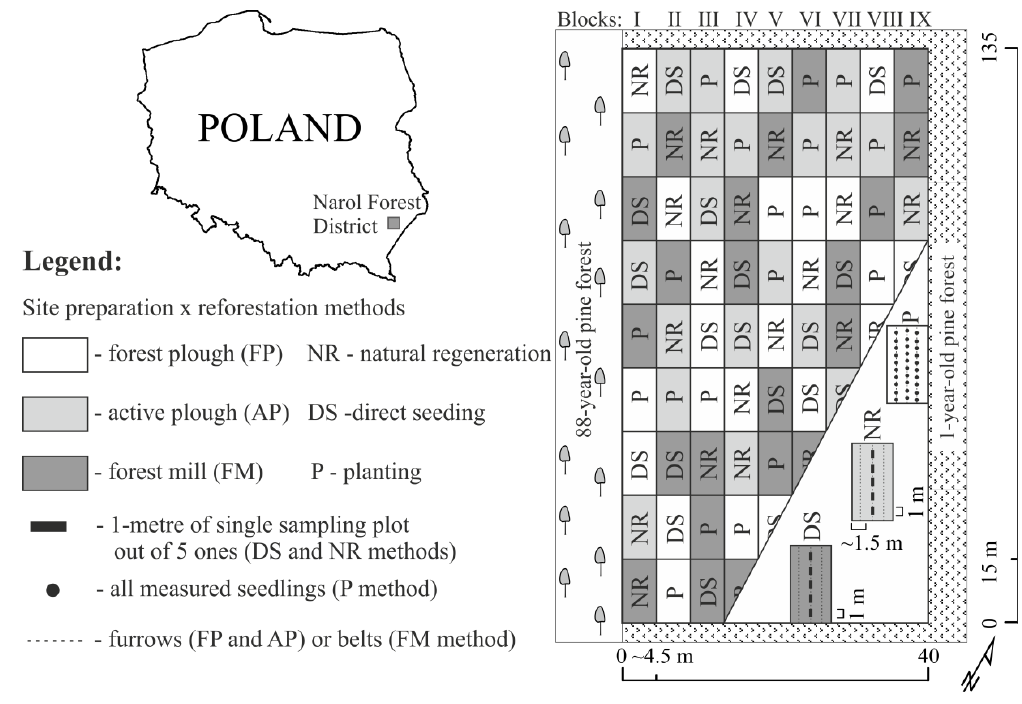
Figure 1. Study location and experimental design.